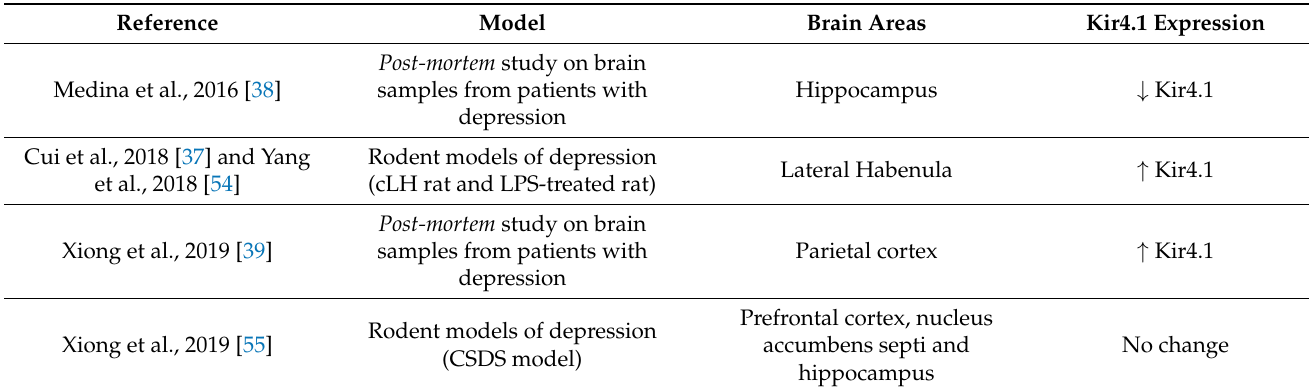
Table 1. Kir4.1 channel expression changes in